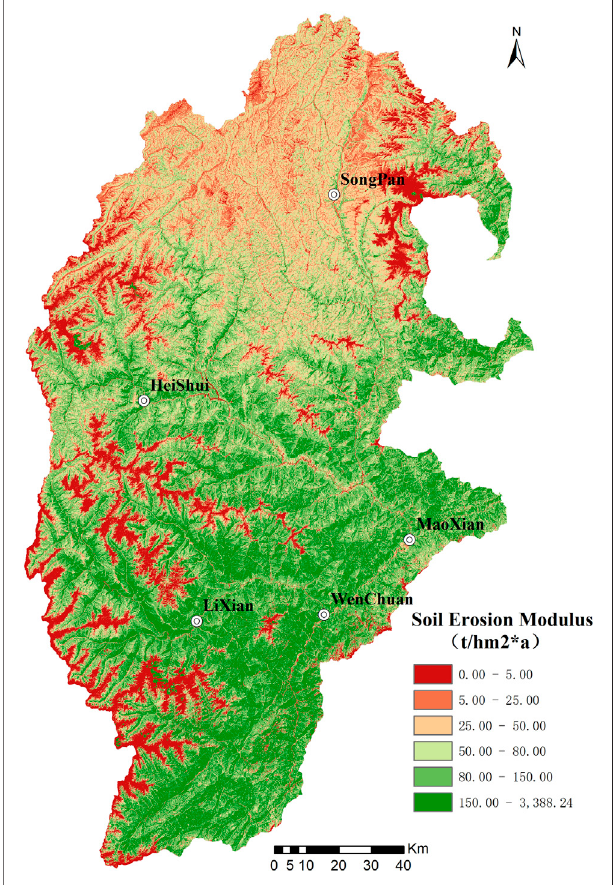
FIGURE 9 | Modulus of soil erosion in the upper reaches of the Minjiang